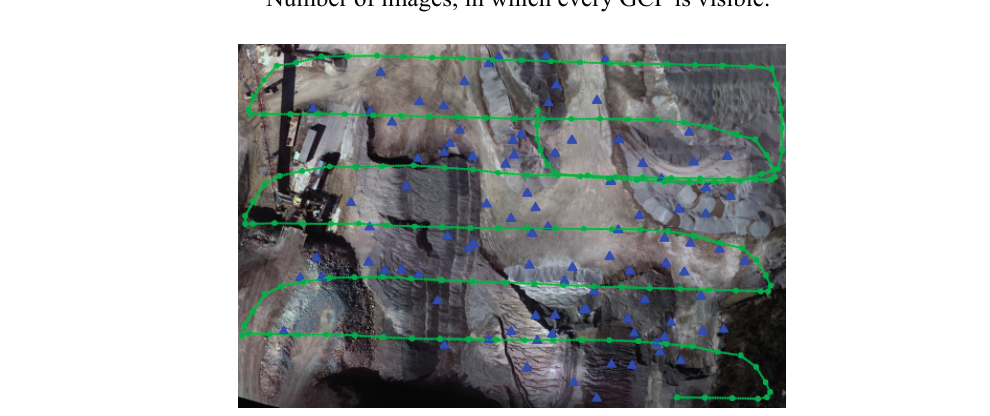
Figure 13. Flight trajectory and distribution of checkpoints in dataset